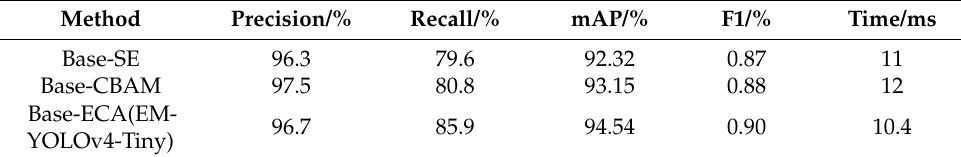
Table 5. Performance comparison after using different attention